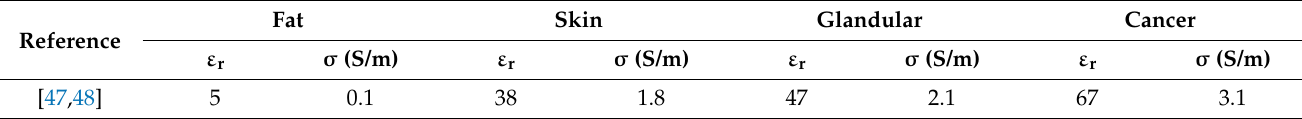
Table 4. Dielectric properties of the breast tissues: fat, skin, glandular, and cancer at 3 GHz.